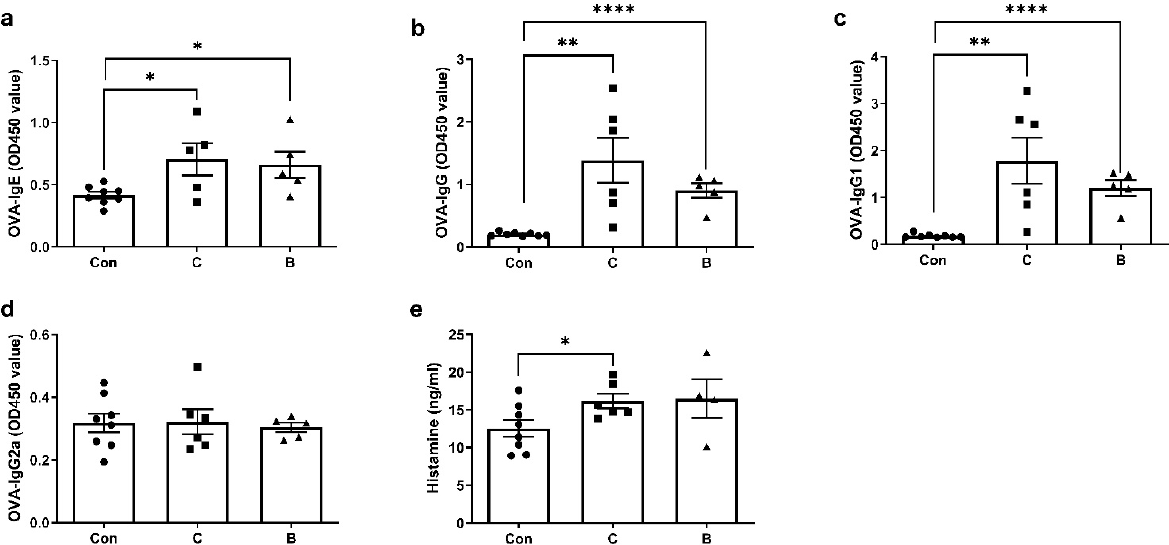
Figure 4. The serum levels of specific antibodies and histamine were similar in the group with long-term administration of DSS (group C) and the group with a 7-day administration of 3% DSS (group B). OVA-specific ( a ) IgE, ( b ) IgG, ( c ) IgG1 and ( d ) IgG2a levels, and ( e ) histamine concentration in mouse serum. The value was shown as the mean ± SEM for 5–8 animals per group. ● represents the individual in group con, ■ represents the individual in group C, ▲ represents the individual in group B, * p < 0.05 ** p < 0.01; **** p < 0.0001.